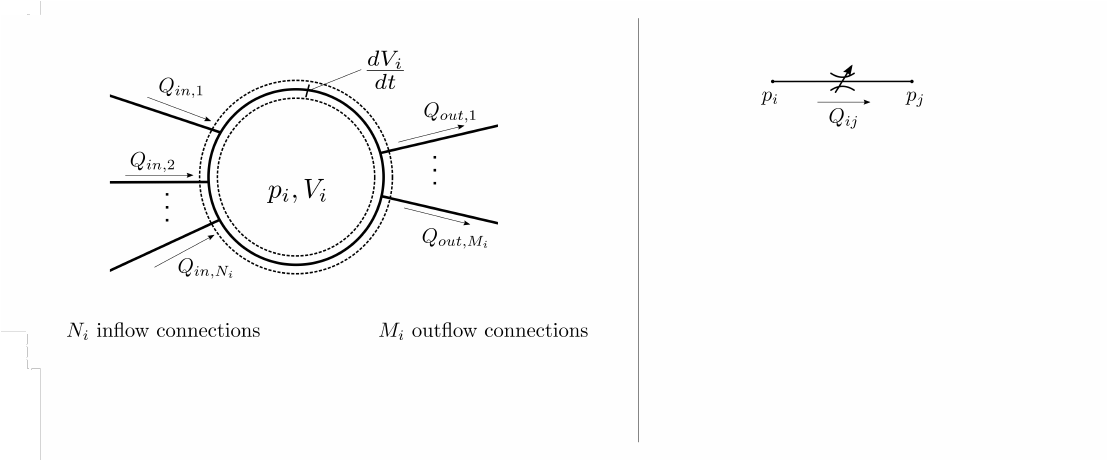
Figure 1. Schematic representation of the governing equations in the conventional lumped parameter approach: Pressure built up equation and the Orifice